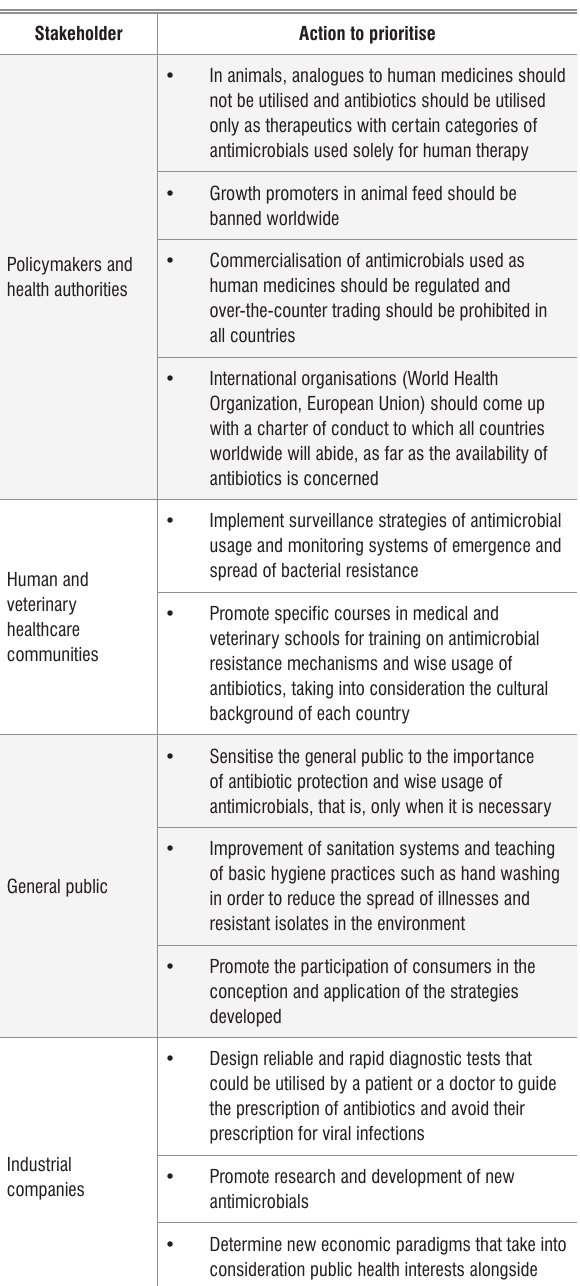
Actions prioritised at the Third World Healthcare Associated Infections Forum with respect to antimicrobial